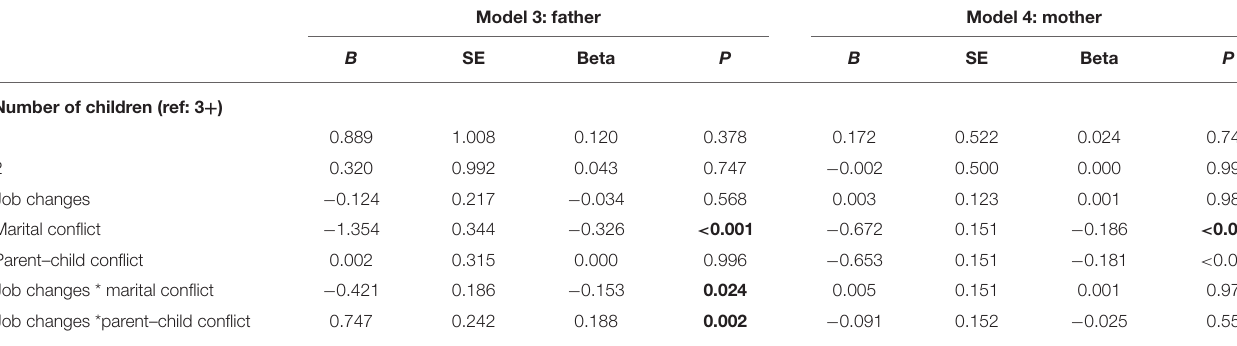
TABLE 4 | Interaction effects analysis between job changes and family conflicts on quality of life in the gender subgroup.